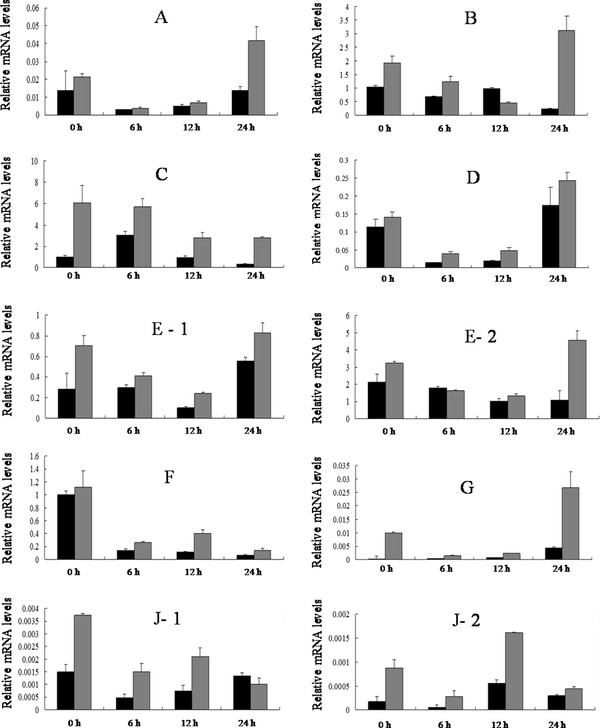
The expression of 10 differentially expressed spots at the corresponding mRNA level. A represents spot 1.B represents spot 2 and 9. C - Grepresent spot 3 - 7 respectively. J represents spot 10. A, serine/threonine kinase-related protein.B, ribulose-1,5- bisphosphate carboxylase/oxygenase large subunit. C, Vegetative storage protein A. D, cytosolic phosphoglycerate kinase.E- 1, ATP synthase beta subunit. E- 2, malate dehydrogenase. F, phenylalanine ammonia-lyase.G, S-adenosylmethionine synthetase.J- 1, ascorbate peroxidase. J- 2, 20S proteasome alpha subunit. Error bars represent the SD. The scales are different for the different genes.